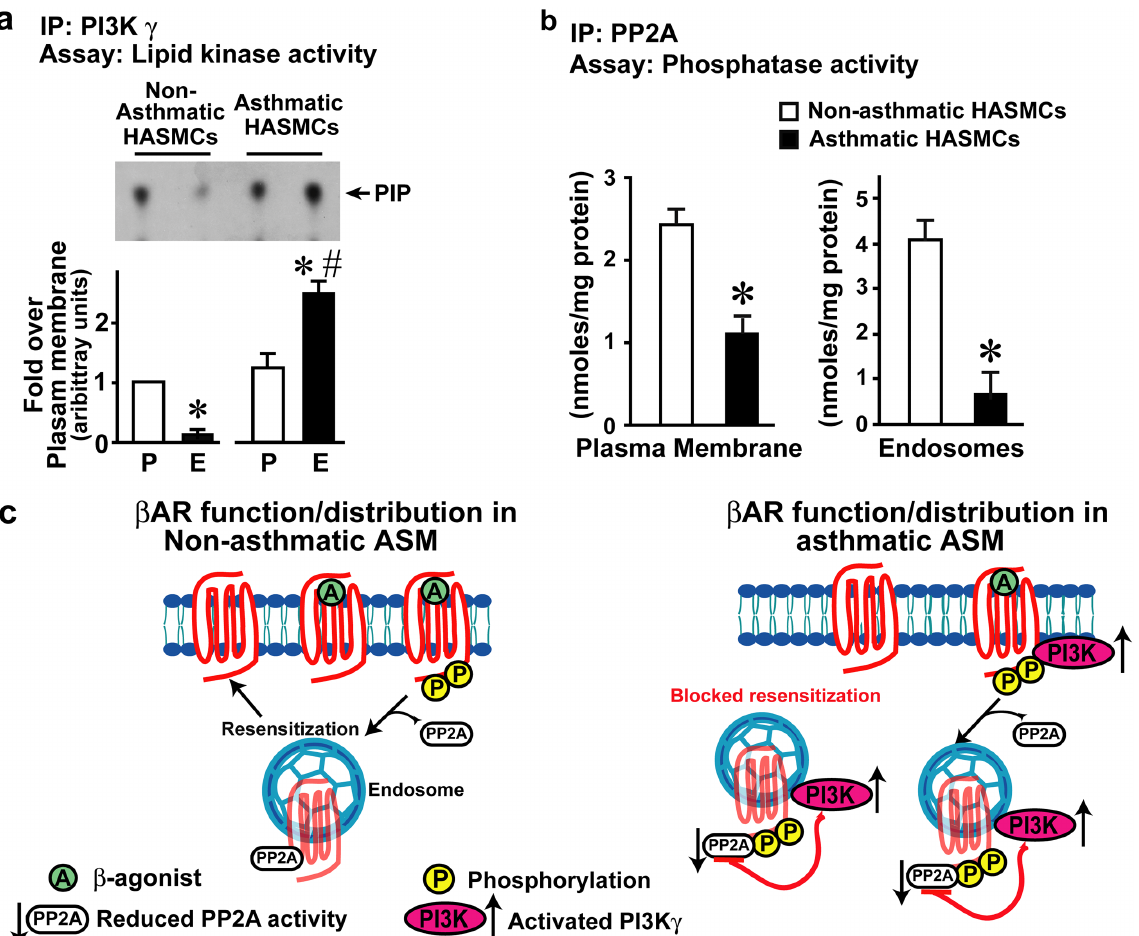
Fig 5. Measure of β AR resensitization in Non-ASM and ASM HASMCs (measure of resensitization components PI3K γ and PP2A activity). a , Upper panel, PI3K γ was immunoprecipitated from plasma membrane and endosomes isolated from non-asthmatic ASM and asthmatic ASM cells (120 μ g) and the washed immunoprecipitates were subjected to in vitro lipid kinase assays. Lower panel, densitometry for PI3K γ (n = 4/group). * p < 0.01 vs. plasma membrane (P) non-asthmatic ASM, #p < 0.0001 vs. endosomes (E) non-asthmatic ASM. b , PP2A was immunoprecipitated from (100 μ g) of non-asthmatic ASM and asthmatic ASM cells using anti-PP2A antibodies and the immunoprecipitates were subjected to in vitro phosphatase assay with malachite green as a read for activity, (n = 4/group). * p < 0.001 vs. non-asthmatic ASM,). c , Illustration depicting the loss of resensitization as a underlying cause for β AR dysfunction leading to paradoxical loss in β -agonist response. Left Panel (non-asthmatic ASM conditions), β AR activation by β -agonist leads to desensitization by phosphorylation and resensitization by dephosphorylation via PP2A resulting in normal β ARs recycling. Right Panel (asthmatic ASM conditions), desensitization is well understood but, little is known of resensitization mechanisms. Since we have shown that β AR resensitization is regulated by PI3K γ - PP2A axis, assessment in the endosomes shows marked increase in PI3K γ activity associated with loss in PP2A activity. Based on this observation, we propose that asthma HASMCs are characterized by loss in β AR resensitization wherein, increased PI3K γ inhibits PP2A activity blocking receptor resensitization resulting in accumulation of β ARs in the